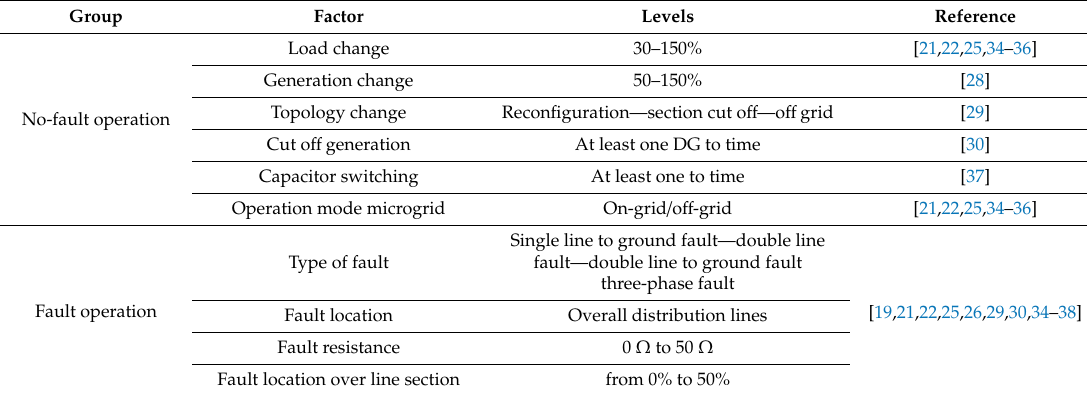
Table 2. Factors and levels commonly used.